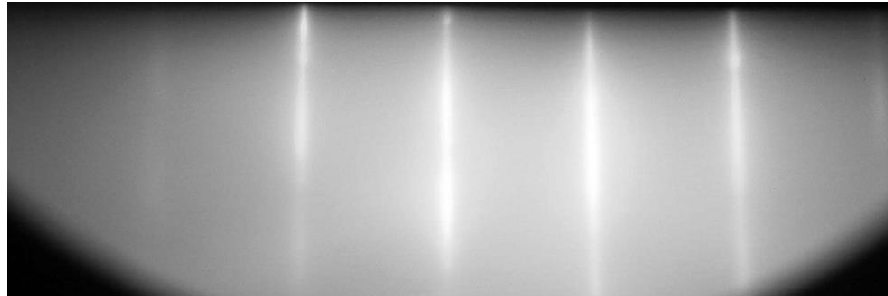
Figure 7. RHEED pattern of the 3C-SiC/Si(111) sample produced at t a = 25 min. So, after the preliminary annealing of the Si, a number of silicon vacancies are formed in its surface layer. Then, as a result of the chemical substitution reaction (1), the Si “collapses” to 3C-SiC with a twofold decrease in the volume of the material (the volume of the Si cubic cell with eight atoms is 160 Å 3 , whereas the volume of the 3C-SiC cubic cell with eight atoms is 83 Å 3 ). The “collapse” in the uppermost layer occurs vertically, i.e., the lateral size remains almost unchanged, which provides an even and uniform SiC layer (Figure 4) [13]. In the lower layers, the “collapse” occurs in all directions, resulting in a porous layer under the SiC epitaxial film, consisting of SiC, Si, and voids (Figure 4). The